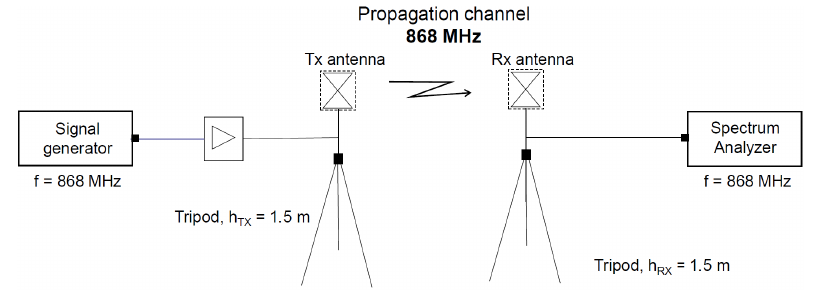
Figure 3. Block diagram of narrowband transmission.